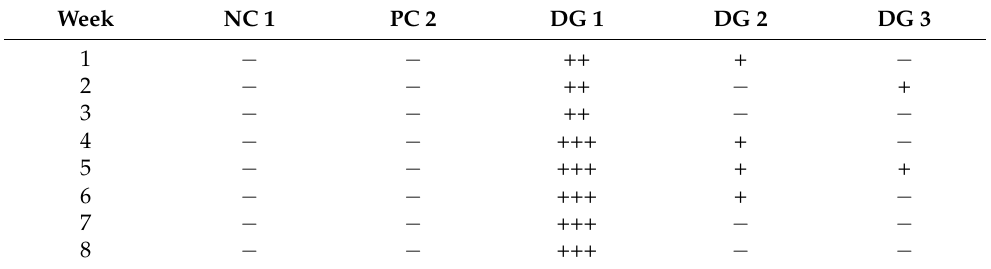
Table 5. Urine analysis showing glycosuria in the studied groups using urine dipstick test.